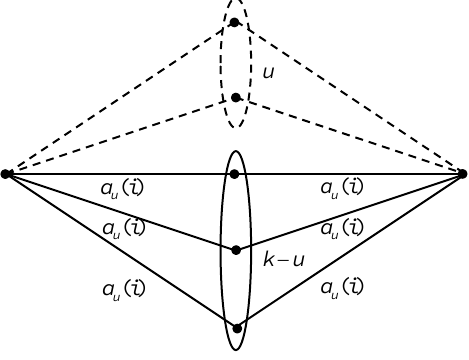
Figure 6. Channel graph of the three-stage switching fabric from Figure